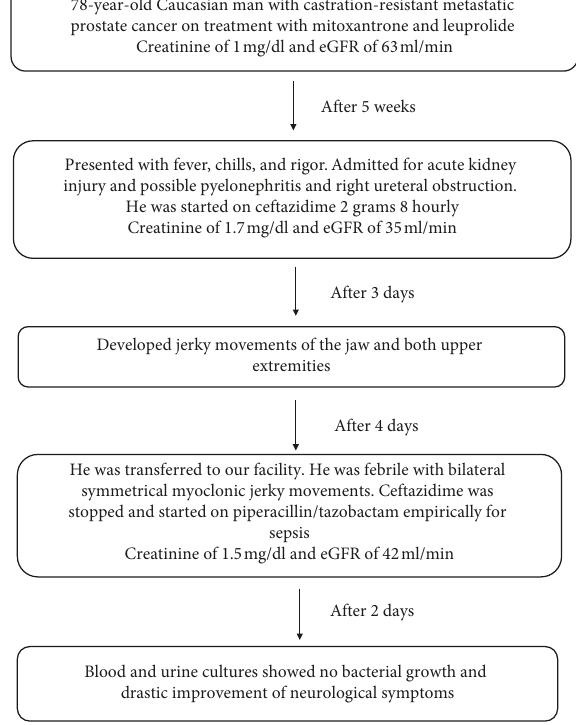
Figure 1: Timeline of case